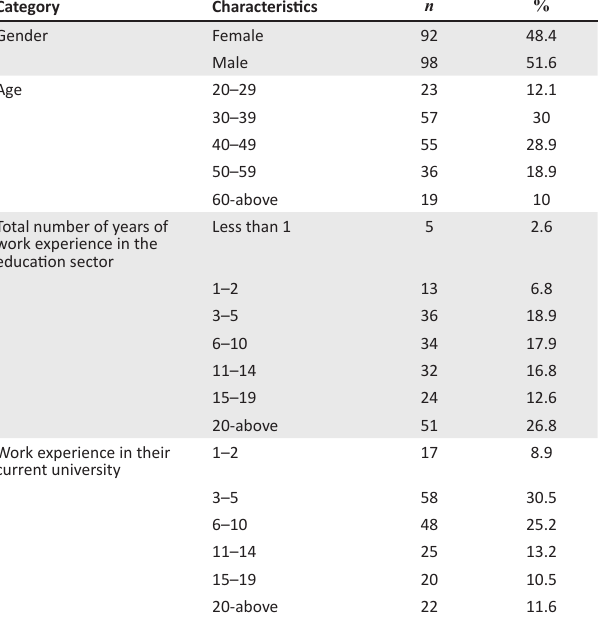
TABLE 1: Sample characteristics. Category